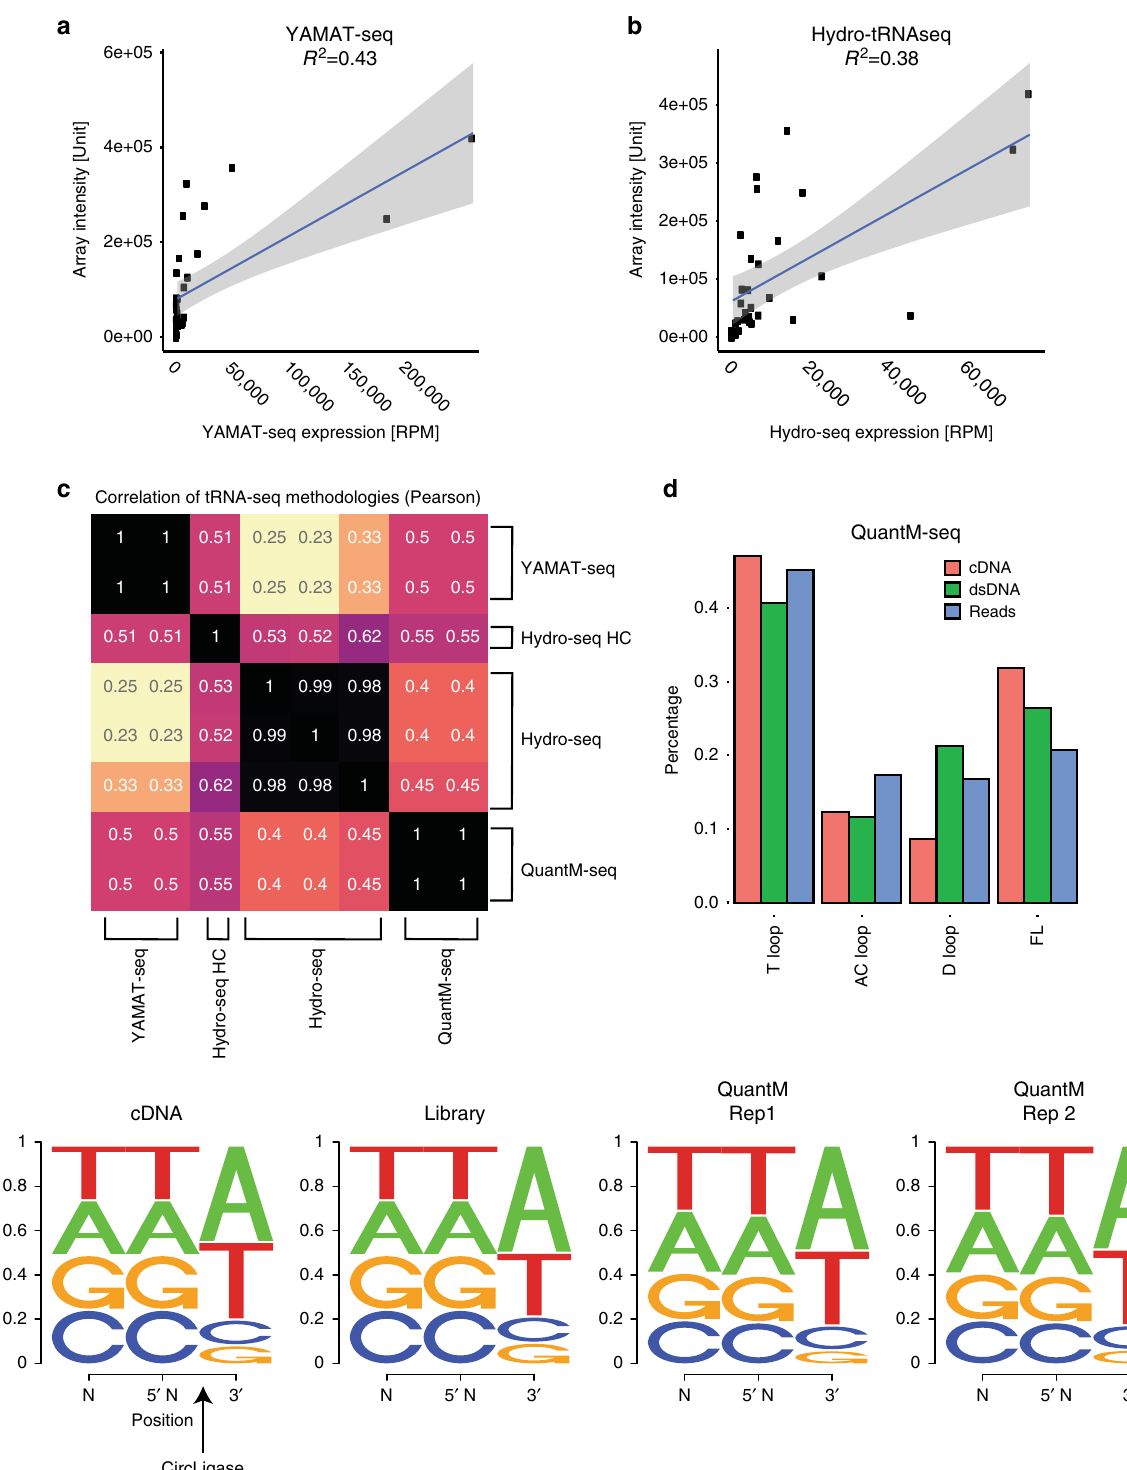
aligned reads to high-con fi dence mouse tRNA genes